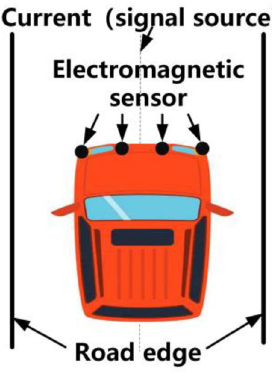
Figure 4 Layout of the electromagnetic detection system